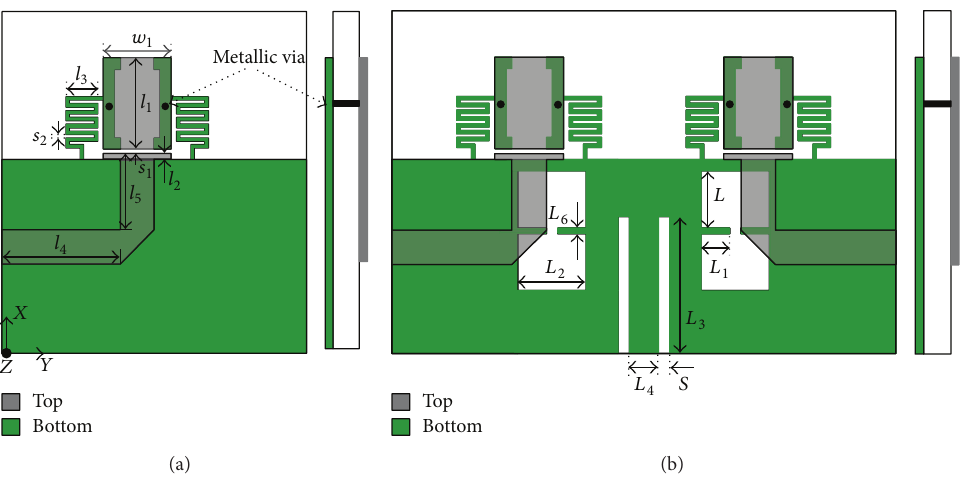
Figure 2: Configuration of the proposed antennas: (a) single metamaterial antenna and (b) metamaterial MIMO antenna.